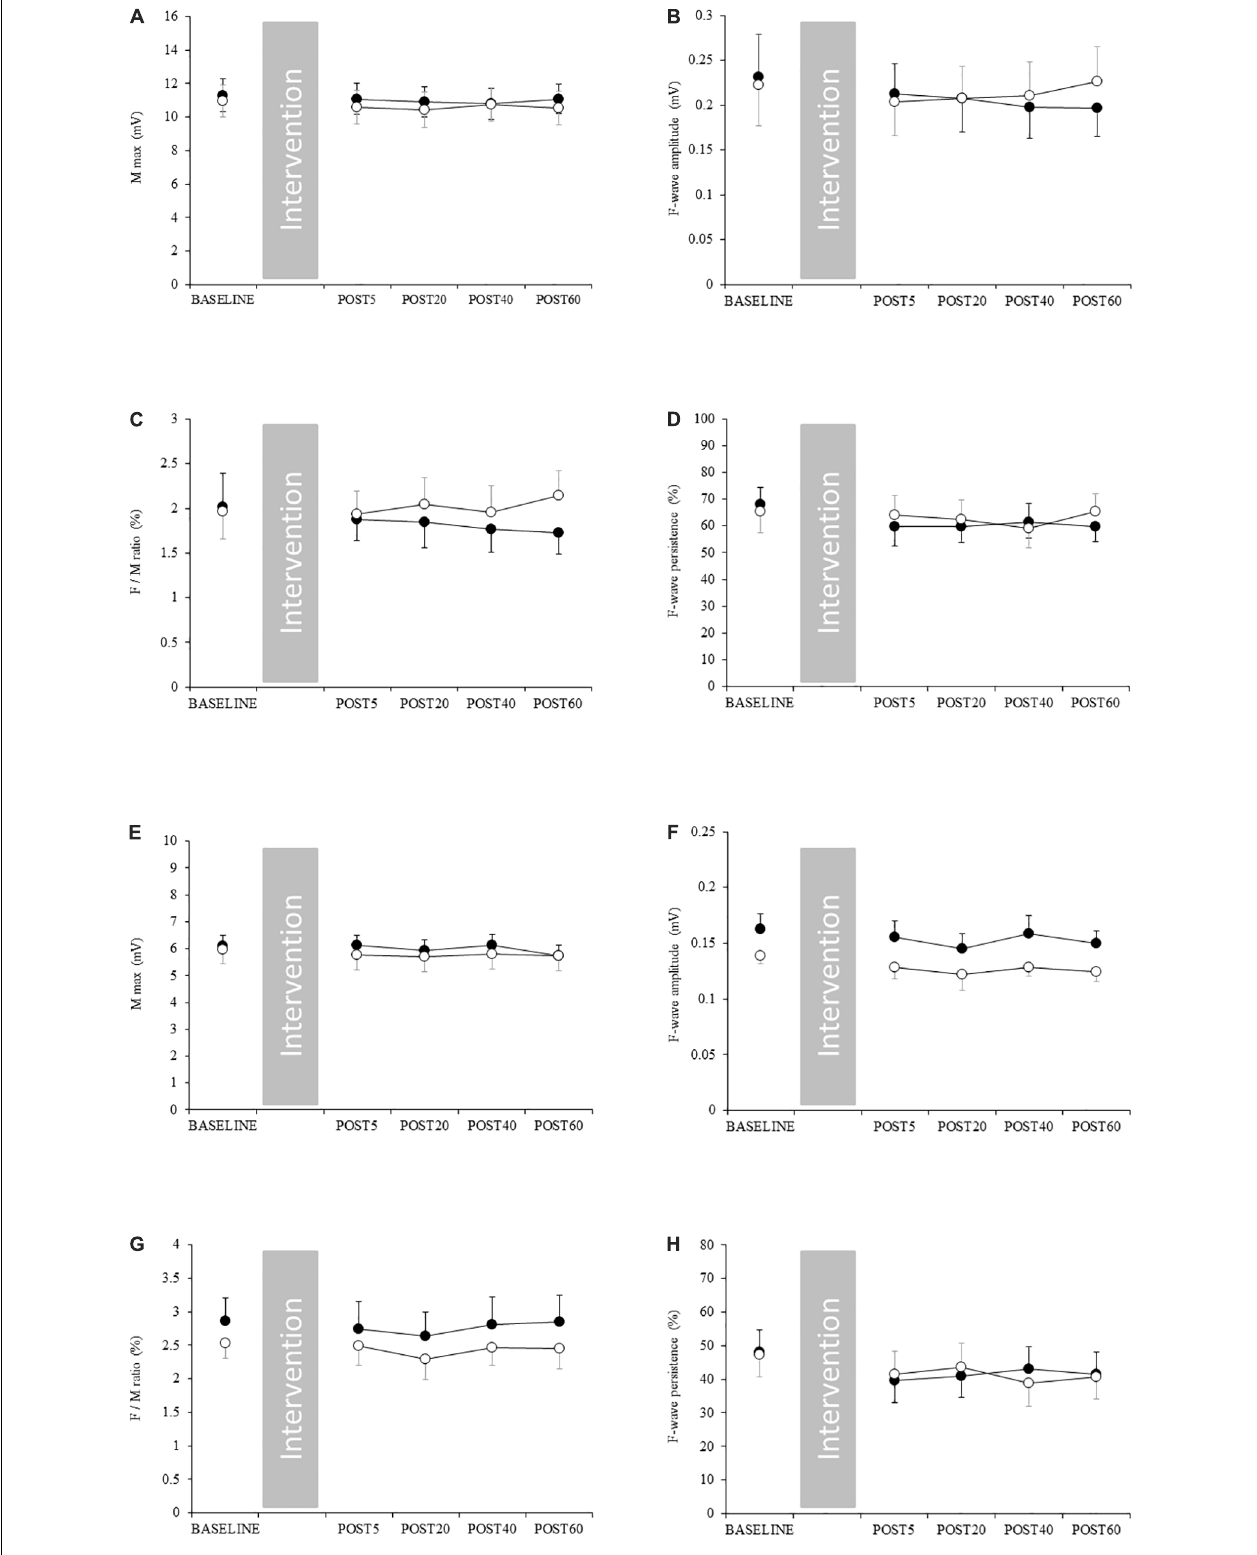
FIGURE 4 | Changes in spinal excitability. Filled and open circles indicate exercise and control conditions, respectively. (A) Mmax, (B) F-wave amplitude, (C) F/M ratio, and (D) F-wave persistence in the upper limb. (E) Mmax, (F) F-wave amplitude, (G) F/M ratio and (H) F-wave persistence in the lower limb.